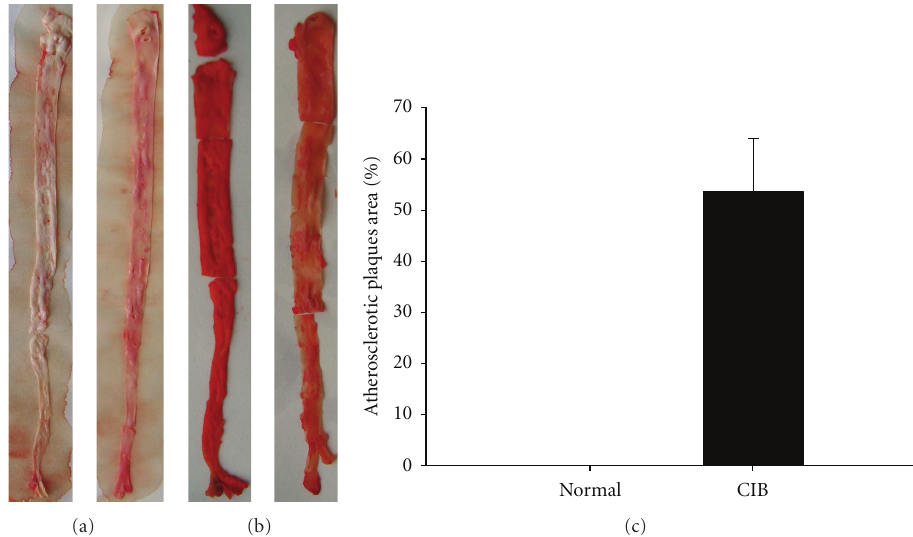
Figure 2: Macroscopic observation of atherosclerotic plaques area and staining with Sudan III. (a) Macroscopic observation of the whole aorta. (b) Representative en face Sudan staining of the whole aorta. (c) Percentage of the atherosclerotic plaques area in both groups. The Ratio of atherosclerotic plaques area to the whole aorta was 54 ± 11% in CIB group, but no atherosclerotic plaques area has been detected in the normal group.